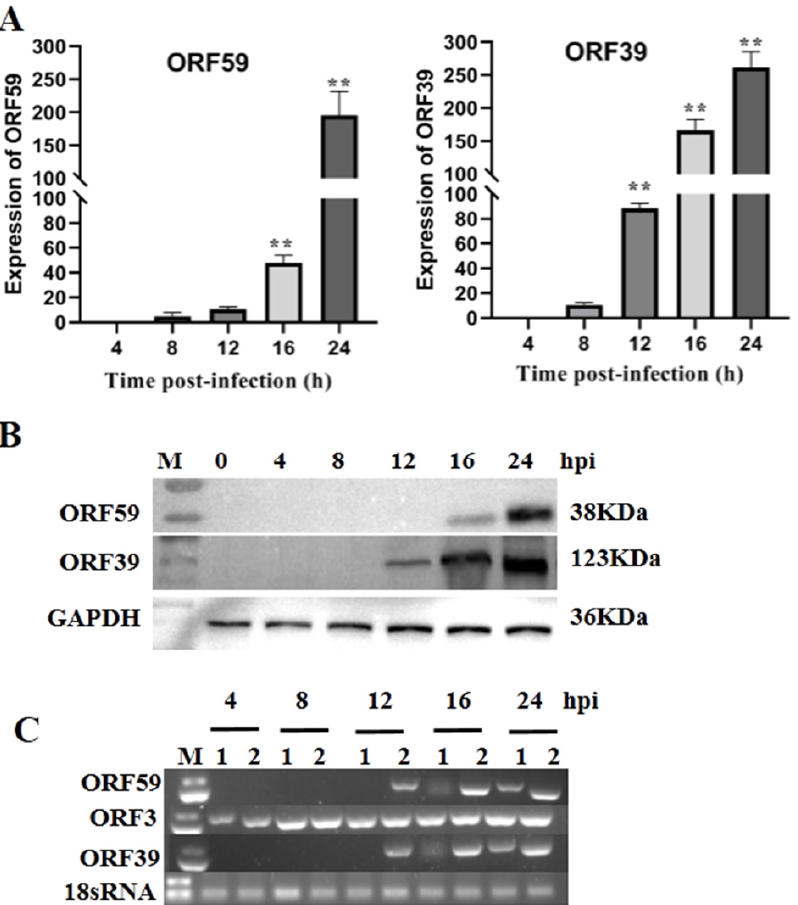
Figure 1. Kinetics of ORF59 expression in infected cells. ( A ) Relative abundance of CCV ORF59 and ORF39 mRNAs. CCO cells were infected with 1000 TCID50/mL CCV and samples were collected at 4, 8, 12, 16, and 24 hpi. The relative fold change was measured using qRT-PCR normalized against 18S rRNA, and data were compared with the 4 h group. Values represent mean ± SD (n > 3) for experiments performed in triplicate. ** p < 0.01. ( B ) CCV ORF59 and ORF39 proteins were analyzed by Western blotting. GAPDH served as an internal reference protein, and protein size markers are indicated (lane M). CCV, channel catfish virus; CCO, channel catfish ovary; hpi, hours post-infection; qRT-PCR, quantitative real-time reverse transcription PCR; GAPDH, glyceraldehyde-3-phosphate dehydrogenase. ( C ) PCR analysis of CCV early and late genes. Total RNA was isolated from CCV-infected (4, 8, 12, 16, 24 hpi.) and mock-infected CCO cells in the presence or absence of cytosine β -D-arabinofuranoside (Ara-C; 100 µ g/mL). The PCR reaction was analyzed on a 1.0% agarose gel. Lane: 1, Ara-C; Lane 2, DMSO. 18sRNA served as an internal reference gene.